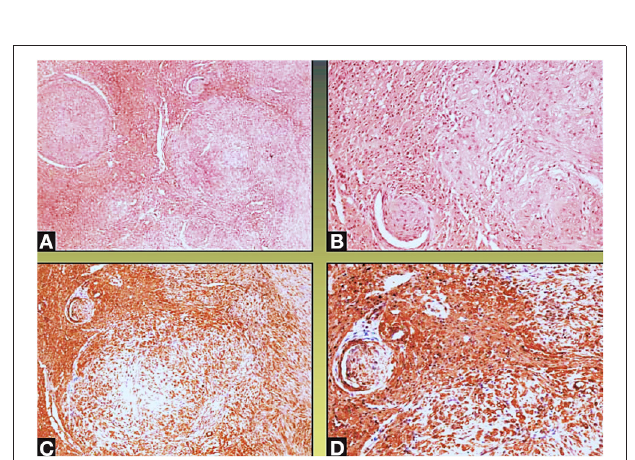
FIGURE 5 | Neoplastic spindle cells infiltrate the small intramural coronary vessels extrinsically, with subsequent flow obstruction and ischemic necrosis of the tributary myocardium (Col Hem-Eos: A,B ; actin: C,D ; original magnification × 10: A,D ; × 40: B,C ).